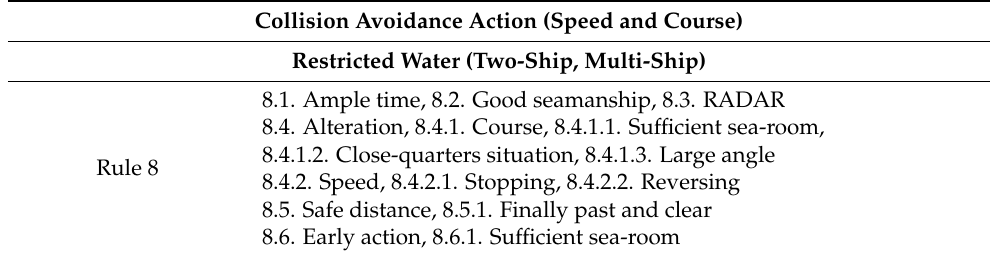
Table 8. Requirements analysis of collision avoidance action (speed and course).